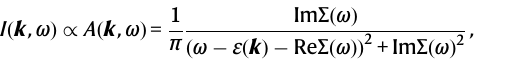
collectedfromanotherindependentsample.DashedlinesareDFTdeterminedFSs. d ARPES intensity plot, corresponding to the black cut in c , showing a kink in the band dispersion.The band dispersionextracted fromthe MDCsis overlaid asared curve. The dashed black line represents the bare band. The arrow indicates the position of the kink. The MDC at E F and its Lorentzian fi t are shown as yellow and black lines, respectively. e Real-part self-energy Re Σ ( ω = E - E F ) and imaginary-part self-energy Im Σ ( ω = E - E F ). A background of Im Σ other is subtracted for Im Σ ( ω ) (see